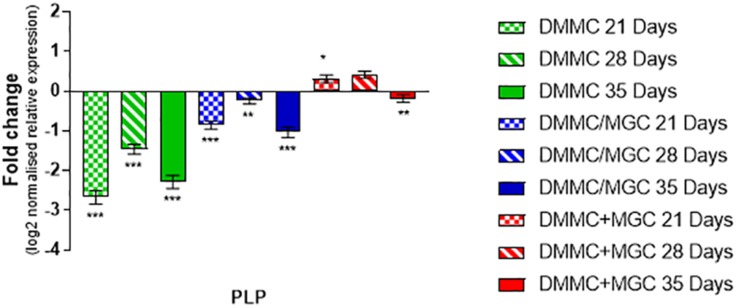
Comparison of PLP gene expression relative to healthy adult mouse brain extract. Statistical comparisons relative to reference brain extract shown on graph only (∗p < 0.05, ∗∗p < 0.01, ∗∗∗p < 0.001).